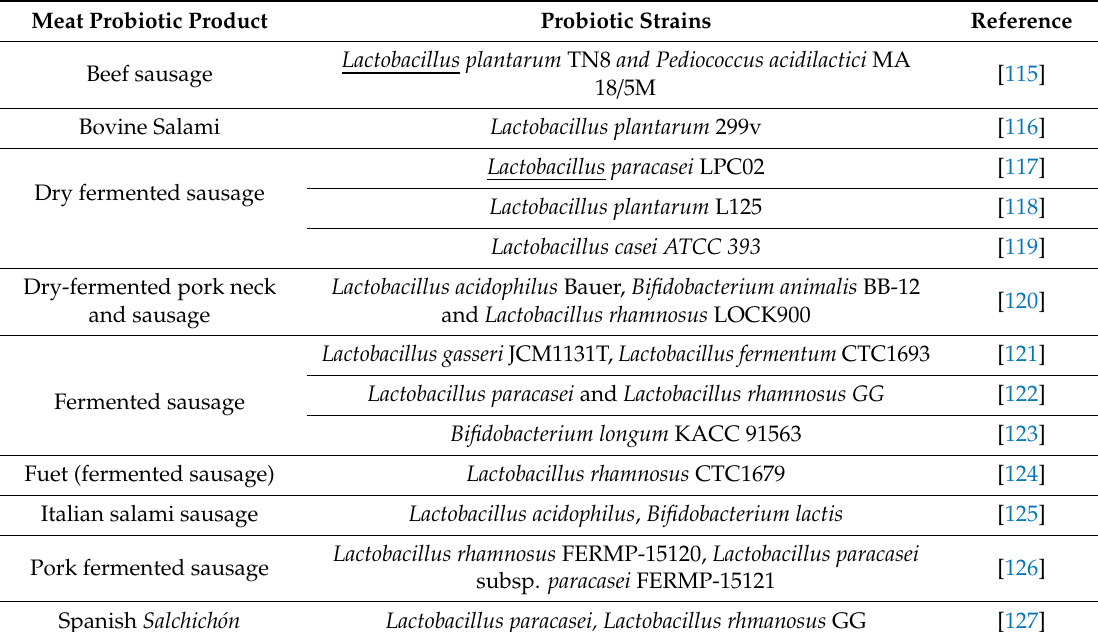
Table 5. Probiotics applied in fermented meat